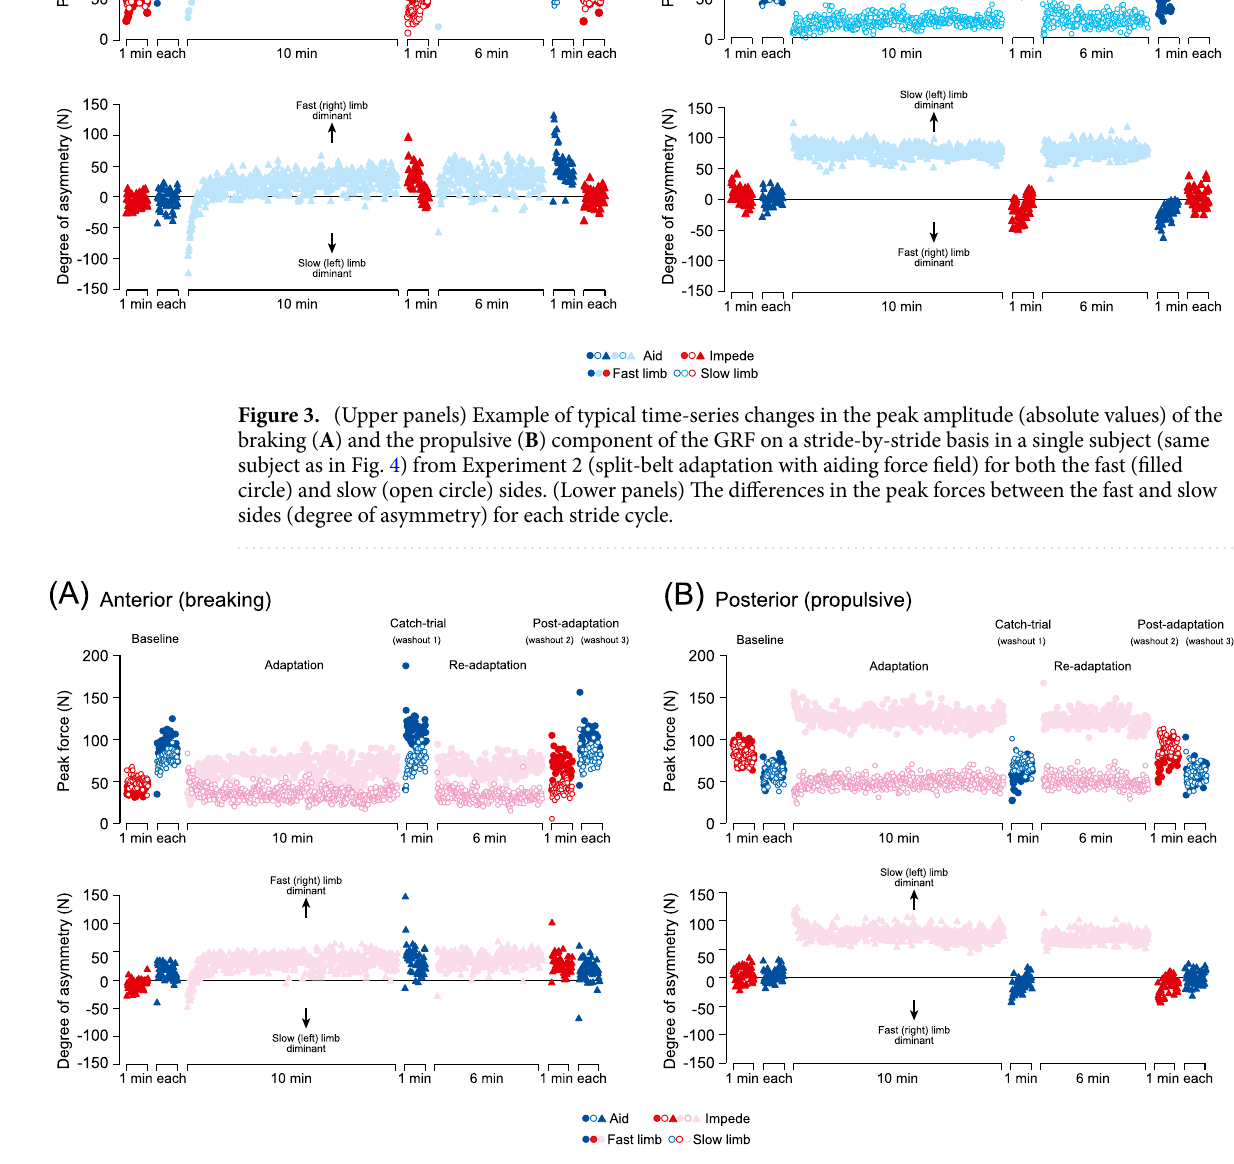
Figure 4. (Upper panels) Example of typical time-series changes in the peak amplitude (absolute values) of the braking ( A ) and the propulsive ( B ) component of the GRF on a stride-by-stride basis in a single subject (same subject as in Fig. 3) from Experiment 4 (split-belt adaptation with impeding force field) for both the fast (filled circle) and slow (open circle) sides. (Lower panels) The differences in the peak forces between the fast and slow sides (degree of asymmetry) for each stride